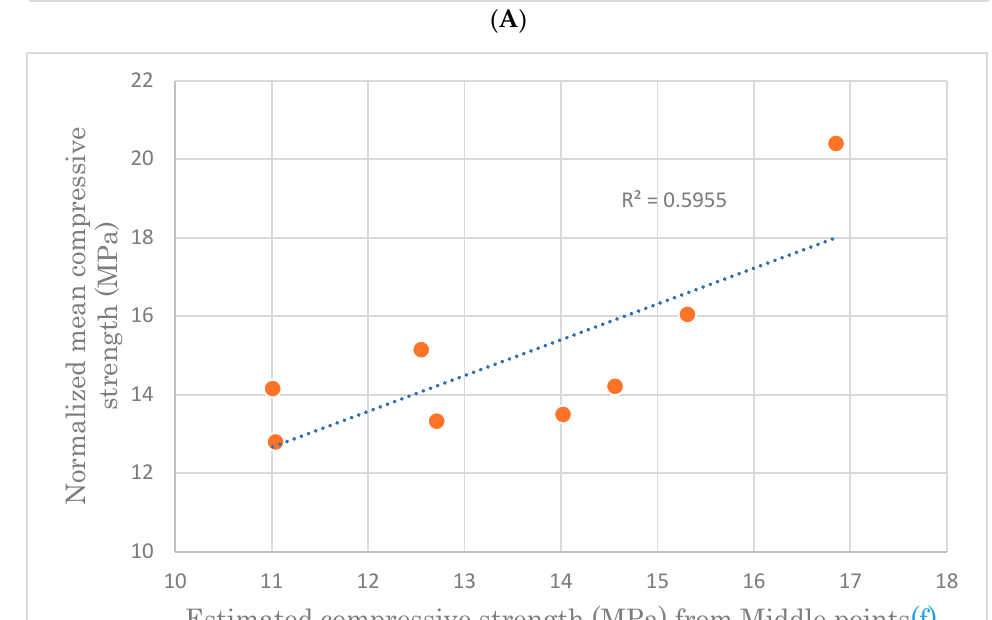
Table 9. Error in estimation of compressive strength.